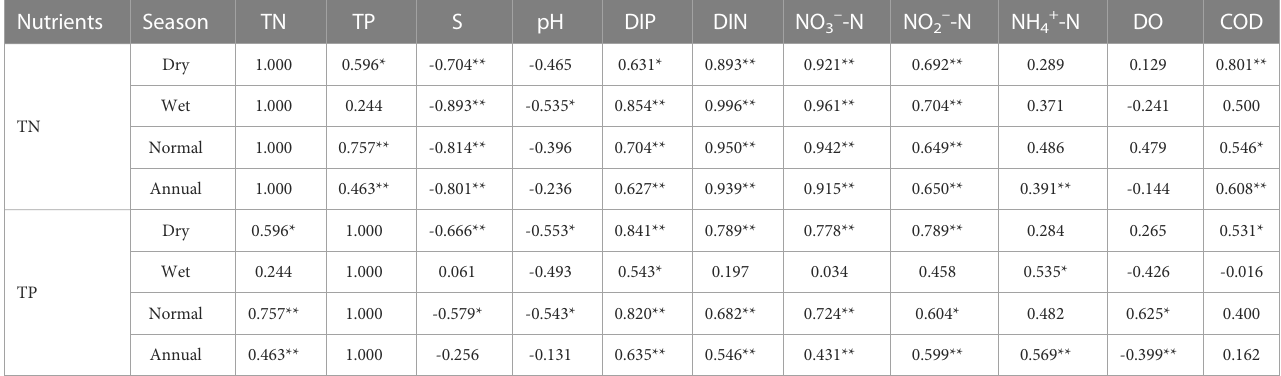
TABLE 3 Spearman correlation relationships between TN and TP and environmental factors in the PRE.